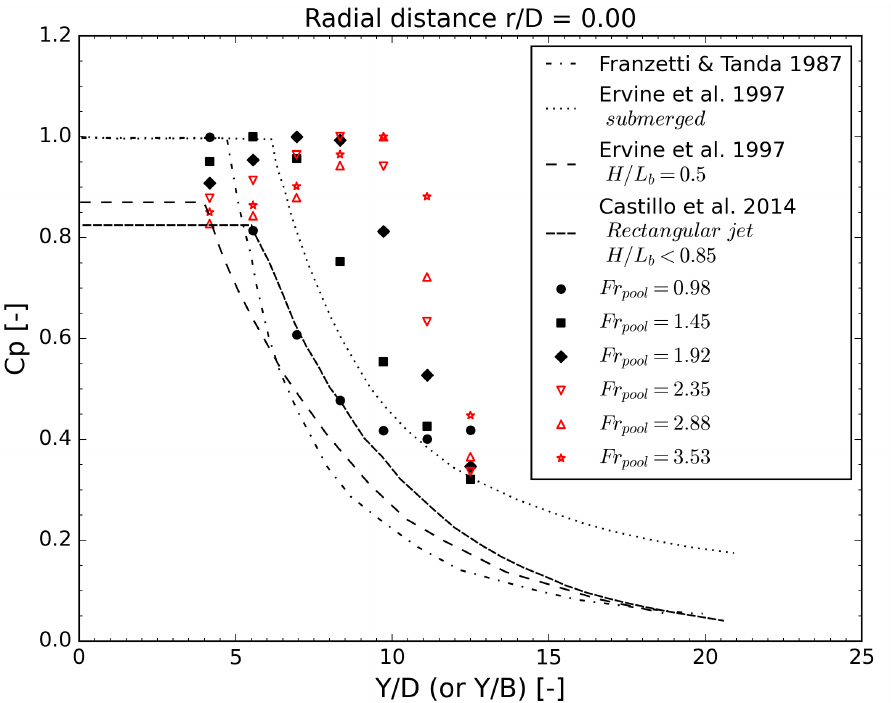
Figure 4. Mean dynamic pressure coefficient Cp [-] as a function of the pool depth ratio Y / D —at a radial distance r / D = 0.00—Jet break-up length ratio H / L b ≤ 0.68.